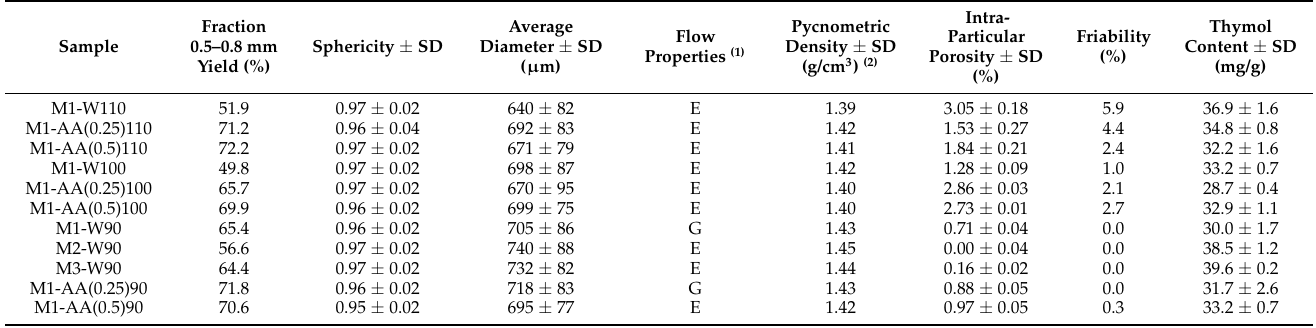
Table 2. Technological characteristics of uncoated pellets .